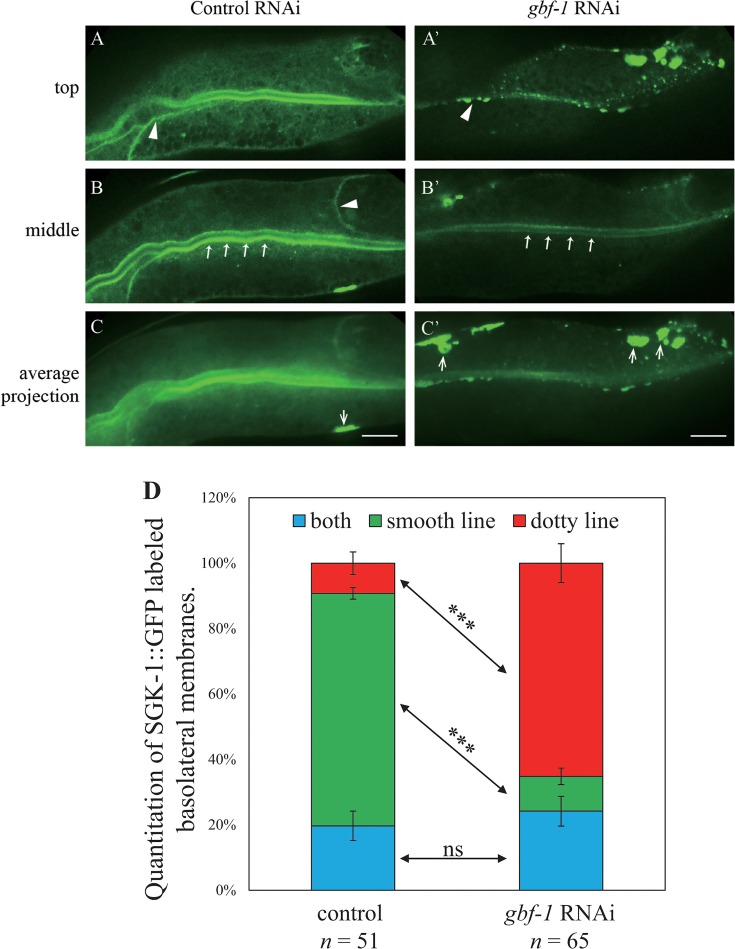
SGK-1::GFP lining the basolateral membrane of intestinal cells was affected by gbf-1 RNAi.Confocal images of intestinal cells of worms expressing SGK-1::GFP treated with control RNAi (A, B, C) or gbf-1 RNAi (A’, B’, C’). Scale bar represents 10 μm. (D) Quantitation of SGK-1::GFP labeled basolateral membranes. Some worms show dotted basolateral membranes in the top plane and smooth lateral membranes in the middle plane and they are named as “both”. *** P value <0.001, ns: non-significant (Student’s t-test).